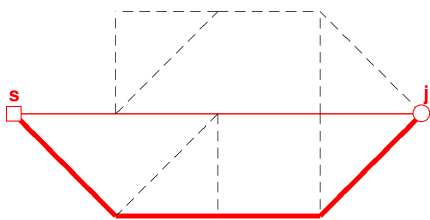
Figure 7. First and second shortest paths from s to j (illustrated with thin and thick solid lines,